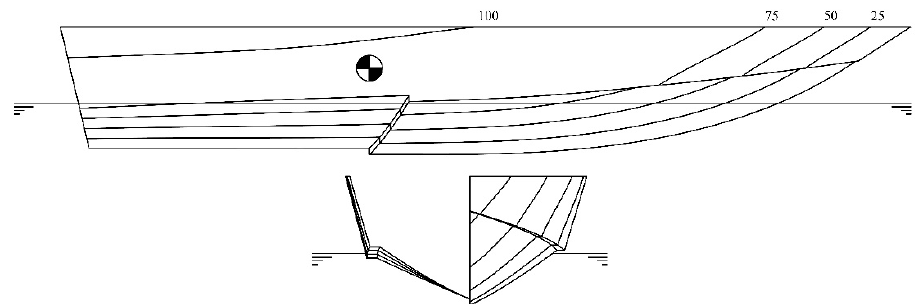
Figure 7. The C03 model body plan (transversal section every 0.100 m) and profile (buttock line every 0.025 m).